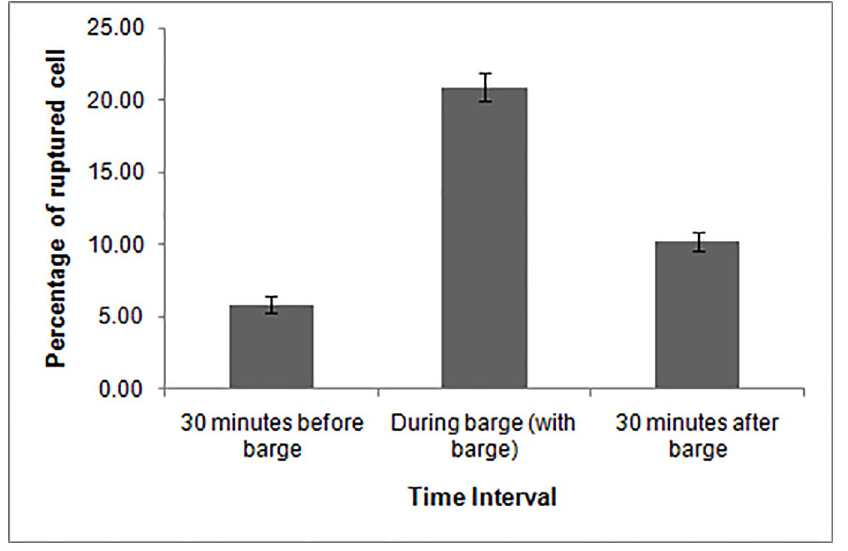
Fig 6. Quantum of phytoplankton cell with respect to barge damaged movement.